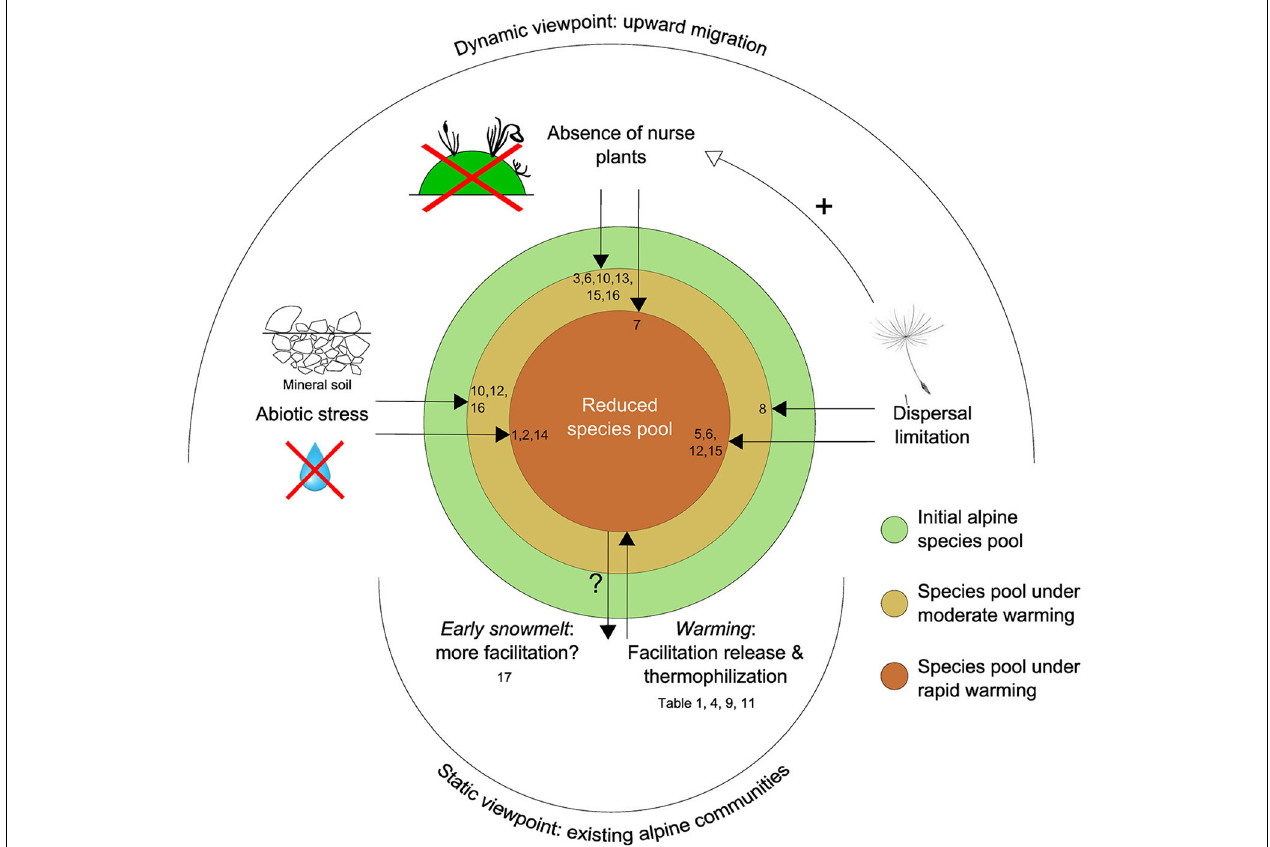
FIGURE 4 | Facilitation as a driver of alpine community structure under two different paces of warming, in established vs. migrating alpine communities. References: (1) Anthelme and Dangles, 2012; (2) Caccianiga et al., 2006; (3) Chapin et al., 1994; (4) Chen et al., 2011; (5) Erschbamer et al., 2001; (6) Erschbamer et al., 2008; (7) Frénot et al.,